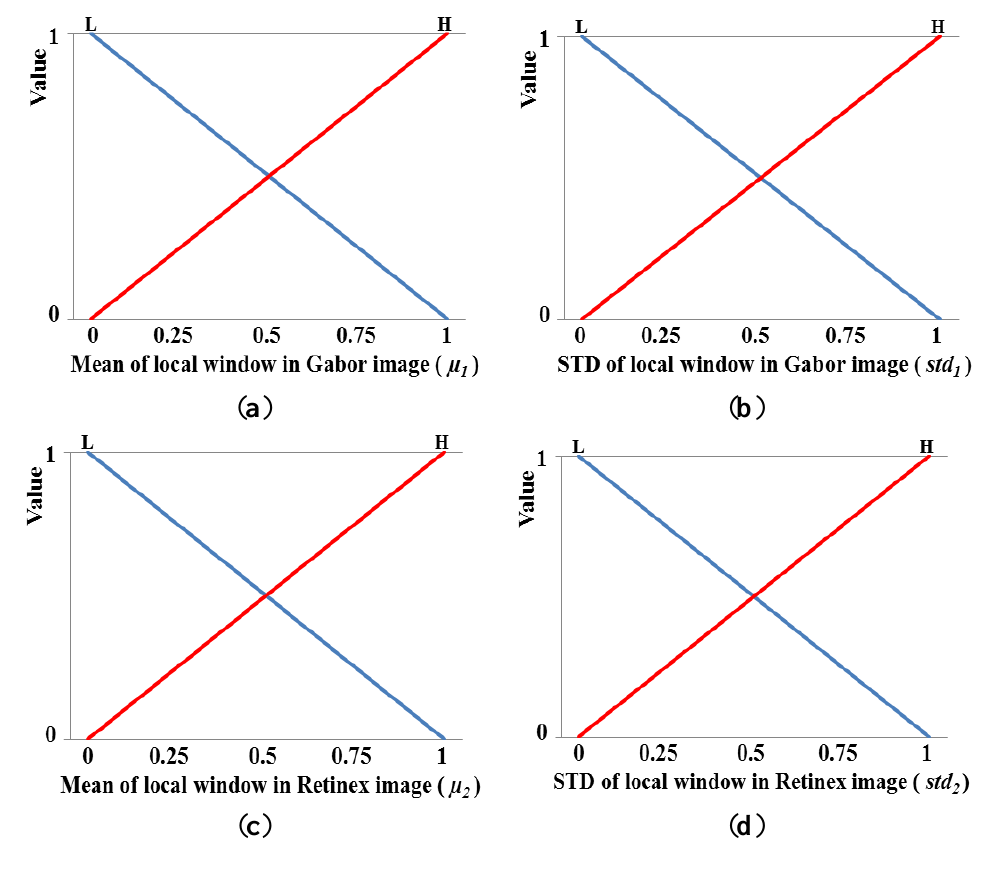
Figure 12. Membership functions used for fuzzy-based image fusion: ( a ) mean and ( b ) standard deviation (STD) of the local window in a Gabor filtered image; ( c ) mean and ( d ) STD of the local window in a Retinex filtered image; and ( e ) membership function for obtaining the optimal